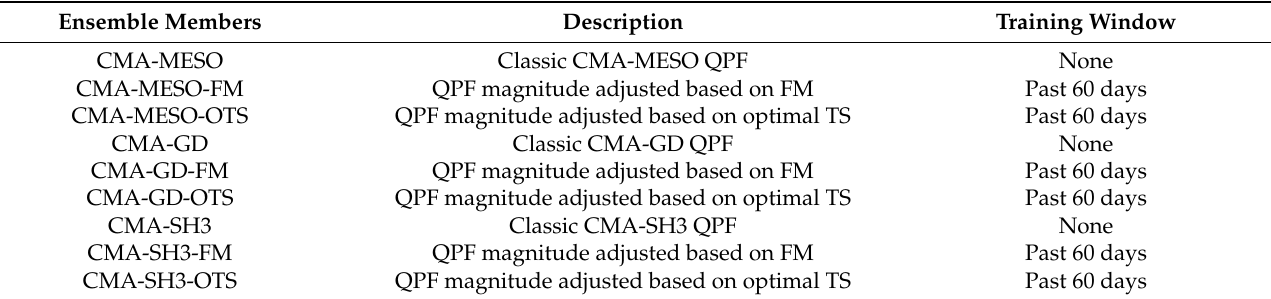
Figure 2. Illustration of ( a ) frequency-matching method (horizontal lines indicate observation and forecast with the same frequency) and ( b ) optimal threat score method (red line indicates threat score in different grades). Table 2. List of multi-model ensemble members for hourly QPF.